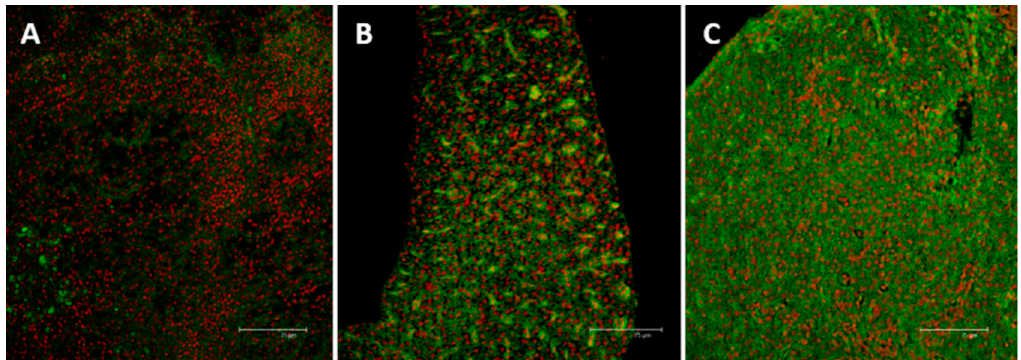
Figure 8. Confocal micrographs of Danio rerio liver sections labeled with a mouse monoclonal antibody against MT ( green —FITC labeled); nuclei labeled with propidium iodide ( red ). ( A ) Control samples revealed no or weak signal in few hepatocytes; ( B ) After 96 h of exposure to 7.7 μ g/L of HgCl 2 , MT immunoreactivity could be observed in hepatocytes cytoplasm; ( C ) After 96 h of exposure to 38.5 μ g/L of HgCl 2 the intensity of staining increased and signal was mainly detected in damaged areas. All bar 75 μ m.